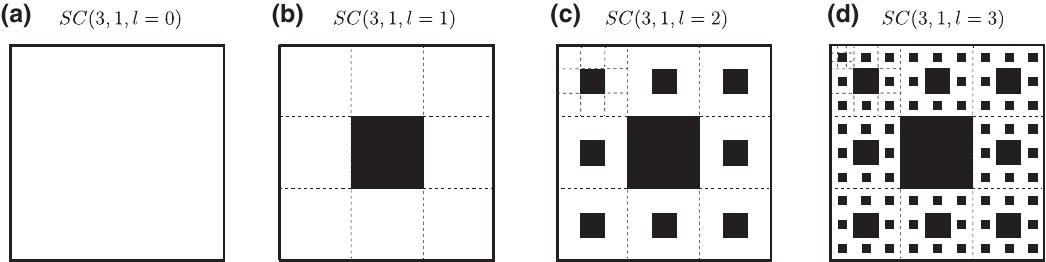
FIG. 3. The recursive definition of the Sierpi´nski carpet SC ( 3, 1 ) . In the l th iteration, we punch level- l holes with linear size 1 / 3 l and obtain the Sierpi´nski carpet at level l . One approaches the Sierpi´nski carpet as l → ∞ .